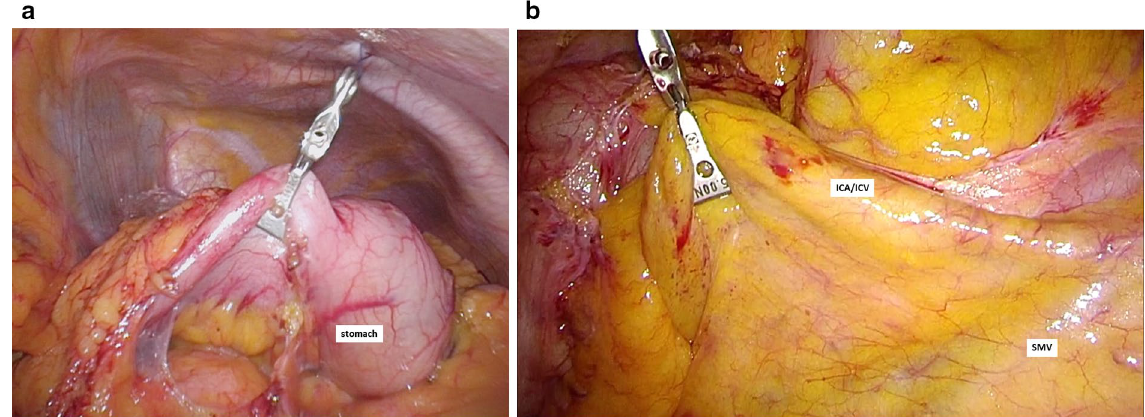
Figure 1. Operative procedure for single-incision laparoscopic right colectomy using an organ retractor. ( a ) To maintain the view of the hepatic flexure, the posterior wall of the stomach is grasped by the organ retractor, and it is trailed extracorporeally. ( b ) The pedicle of the ileocecal artery and vein is grasped by the organ retractor, and the vessels are dissected with the regional lymph nodes. ICA, ileocecal artery; ICV, ileocecal vein; SMV, superior mesenteric